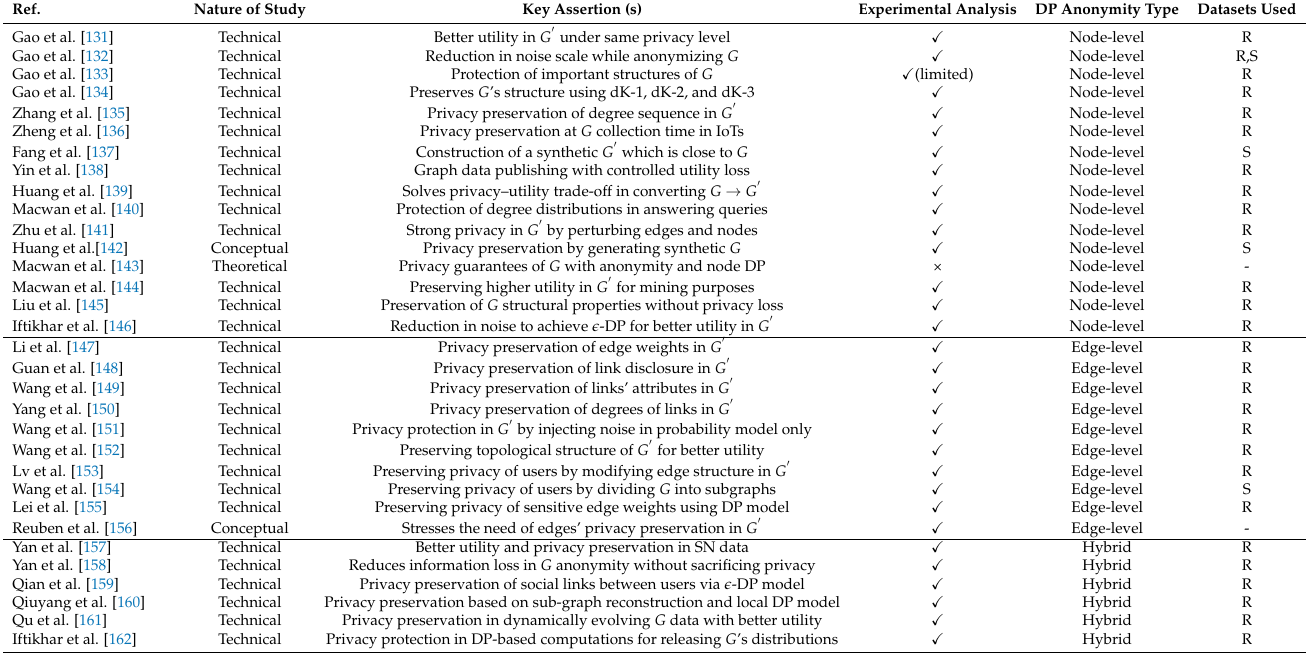
Table 5. Summary and comparison of state-of-the-art DP-based G anonymity techniques. Ref.